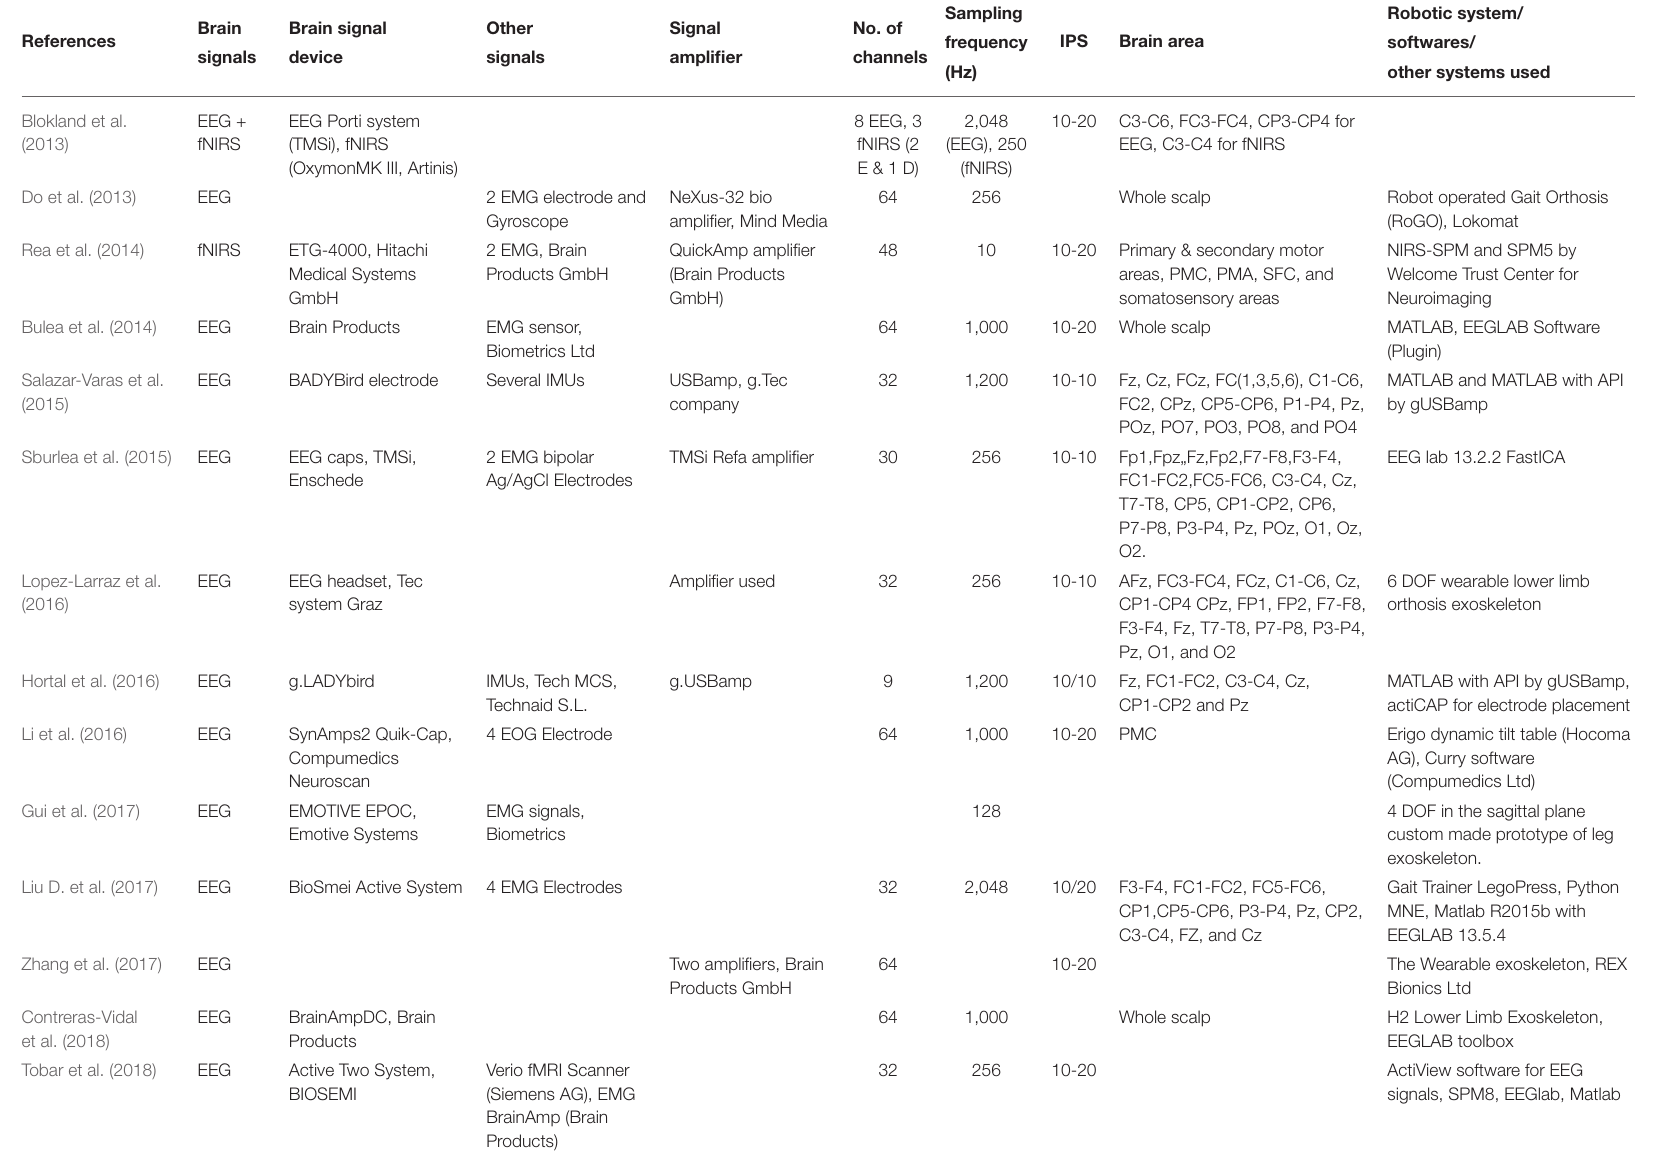
TABLE 5 | Hardware and software description used for signals acquisition for gait